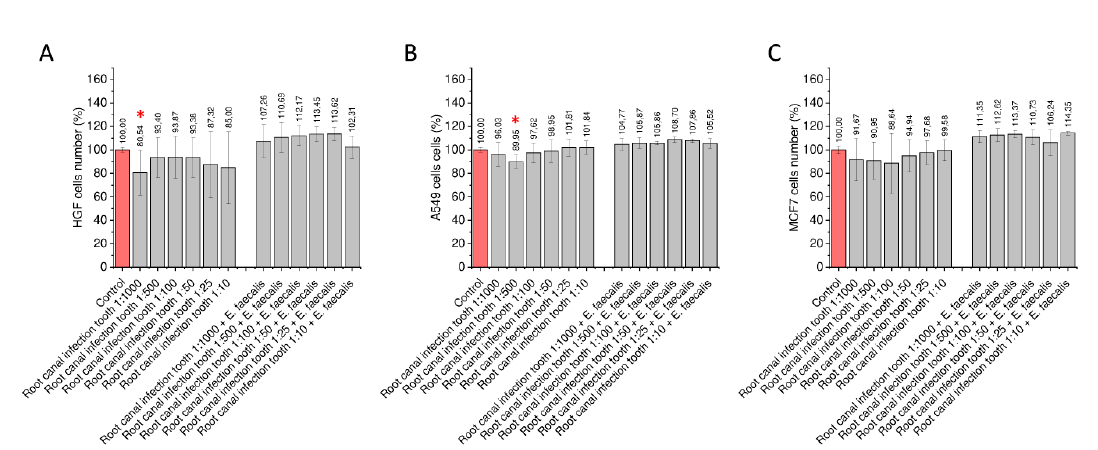
Figure 3. Stimulation of gingival and cancer cells with supernatants of mixed biofilms cultured in the presence of surgically removed tooth in anaerobic conditions and the presence of human saliva. Alterations in proliferation of gingival HGF cells (panel A ), lung adenocarcinoma cells (panel B ), and breast cancer MCF-7 cells (panel C ) upon stimulation with biofilm-derived supernatants. Results are presented as mean ± SD from four individual measurements ( n = 4). * indicates statistical significance ( p < 0.05) compared to unstimulated control cells.